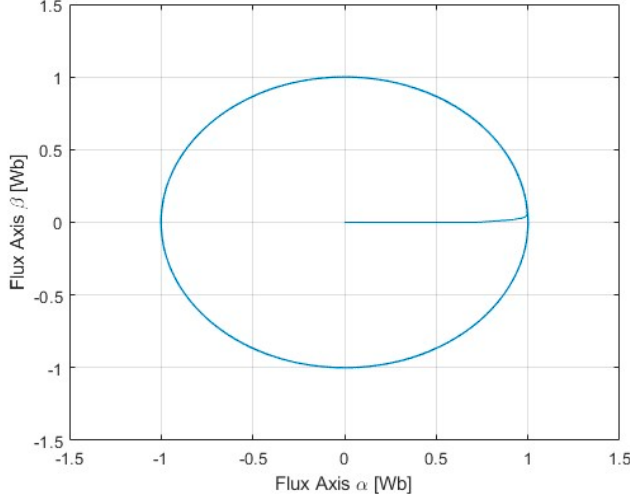
Figure 8. Stator flux circular trajectory.